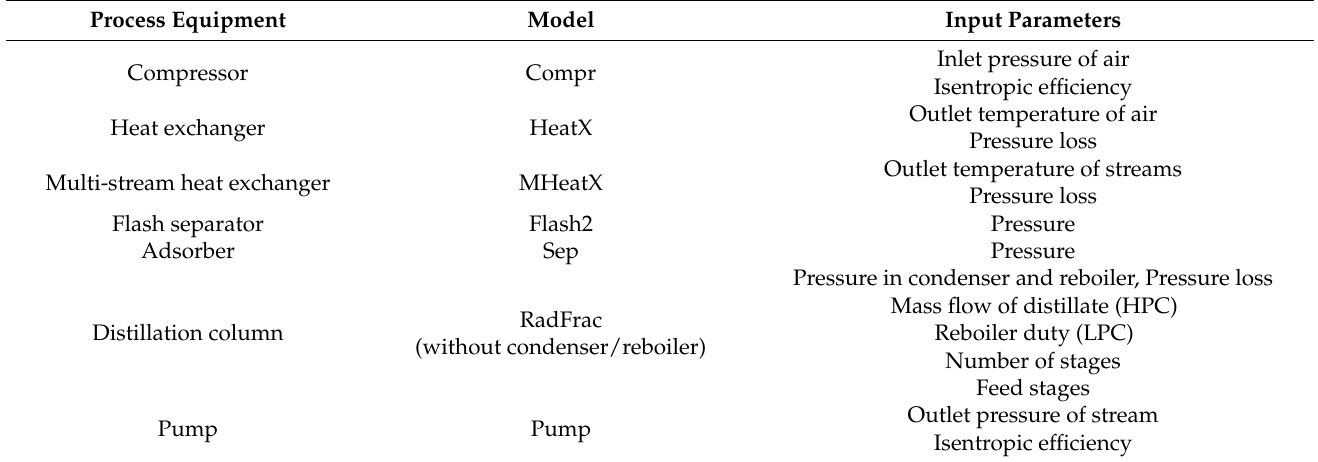
Table A3. Model equipment input parameters. HPC: high-pressure column; LPC: low-pressure